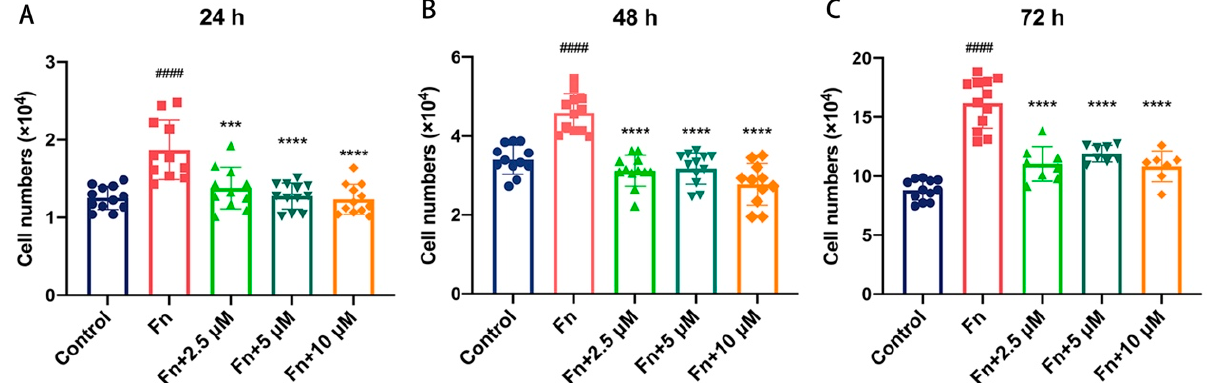
Figure 5. Effects of Br-J-I on the proliferation of human colon cancer cells co-cultured with Fn. Cell number analysis of human colon cancer cells HCT116 co-cultured with or without Fn in the presence of different concentrations of Br-J-I (0, 2.5, 5, and 10 µ M) at 24 h ( A ), 48 h ( B ), and 72 h ( C ) to determine cell proliferation. Each experiment was independently performed three times. All data were shown as mean ± SEM. *** p < 0.001, **** p < 0.0001, vs. Fn group. #### p < 0.0001, vs. Control.